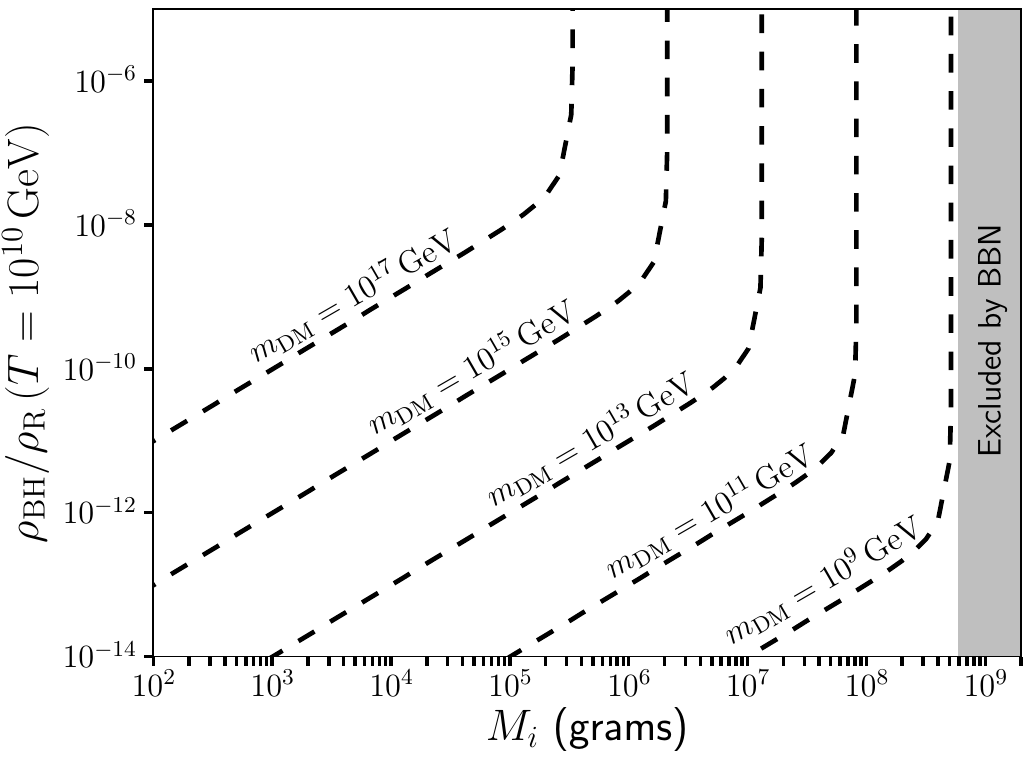
10 GeV) and Figure 3 . The values of the black hole energy fraction ρ BH /ρ R (evaluated at T = 10 0 . 1 for the case of dark matter in the form of initial black hole mass M i that lead to Ω DM h 2 (cid:31) a Dirac fermion with negligible couplings to the SM. Throughout the upper right portion of this plane, the early universe included a period in which black holes dominated the total energy density, and thus the results do not depend on the initial value of ρ BH /ρ R